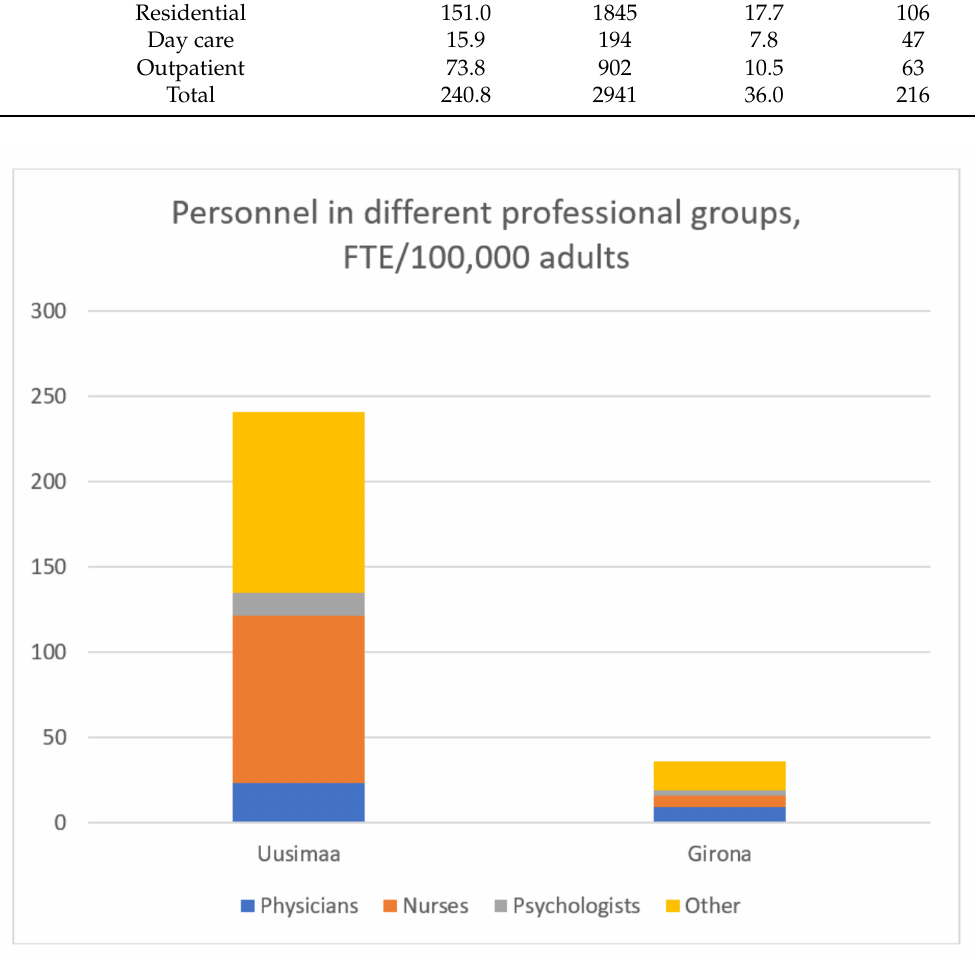
Figure 1. Personnel in different professional groups, expressed as full-time equivalents (FTE)/100,000